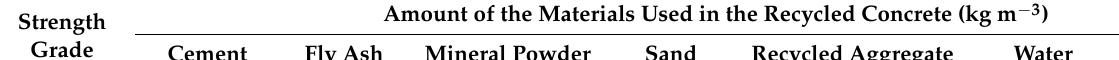
Table 2. Mix proportions of the recycled